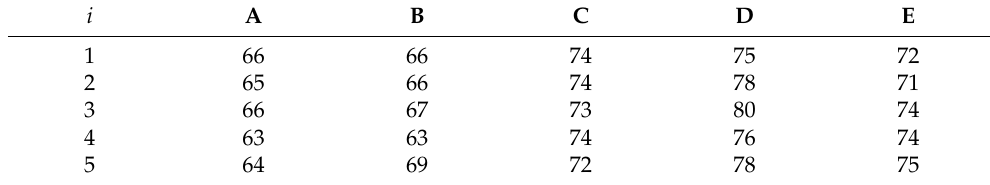
Table 2. Pulse detection results N d of the volunteers.